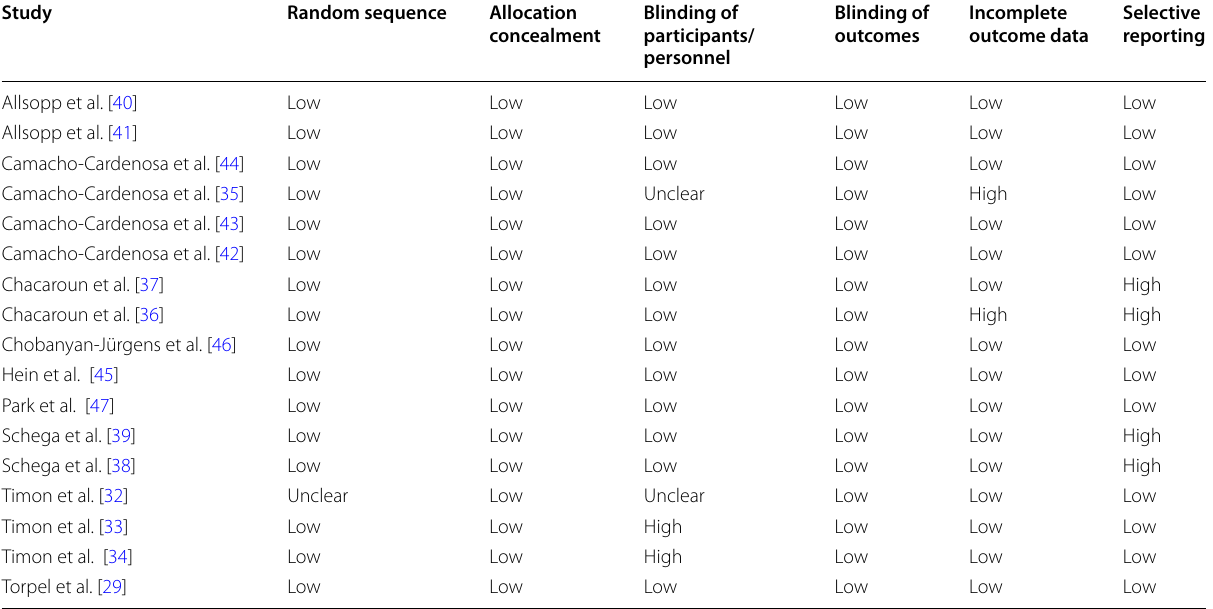
Table 2 Risk of bias assessment of included studies Study Random